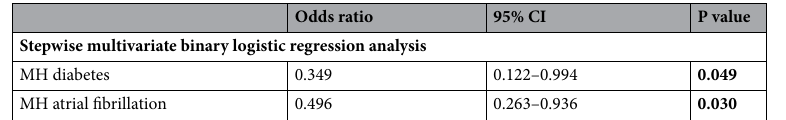
Table 5. Binary logistic regression analysis—predictors for PCS vs. ACS territory. Multivariate stepwise backward binary logistic regression analysis of predictors for stroke in the posterior compared to the anterior cerebral circulation (PCS vs. ACS). The influence of age, sex, diabetes, atrial fibrillation, hypertension and prior stroke or TIA on the stroke territory was investigated. Data are expressed as odds ratio and the 95% CI of the odds ratio. 95% CI indicates 95% confidence interval; MH, medical history. P values < 0.05 are shown in